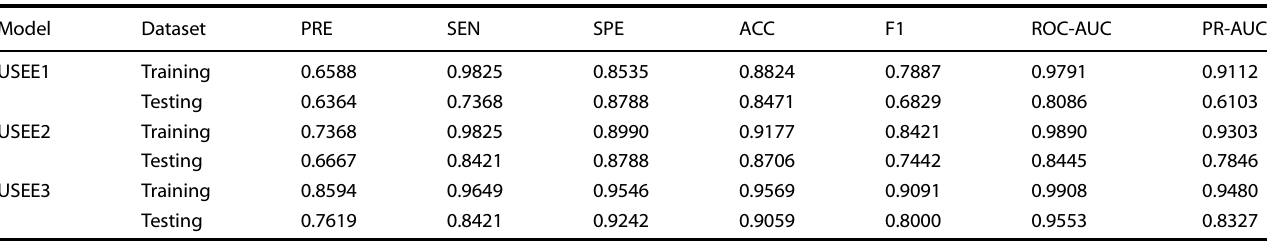
Table 2. Comparison of the classi fi cation effects of various data